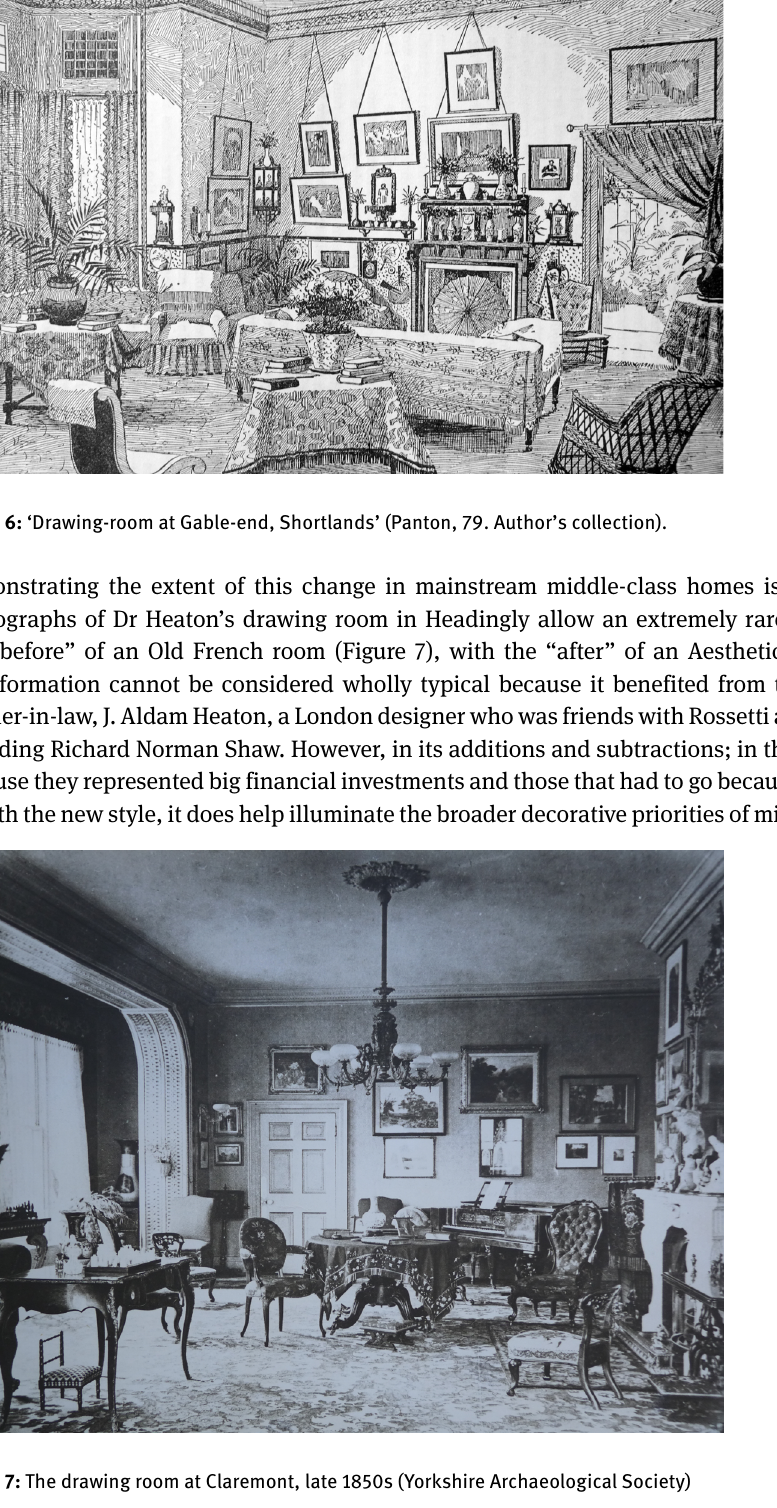
Figure 7: The drawing room at Claremont, late 1850s (Yorkshire Archaeological